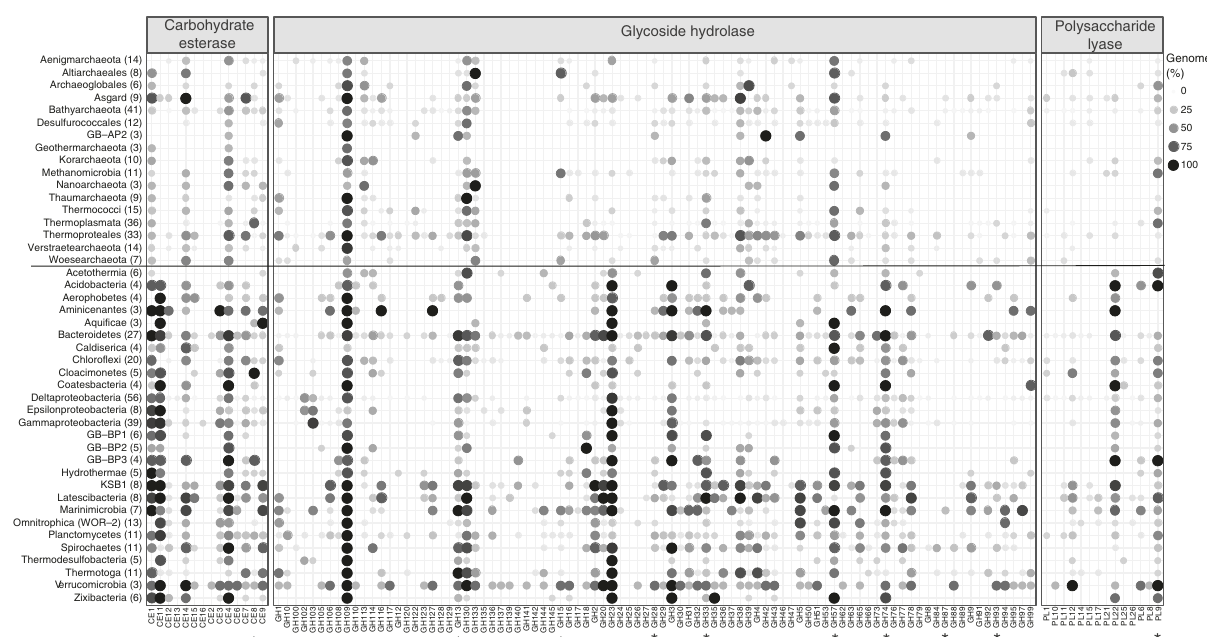
Fig. 3 Number of carbohydrate-active enzymes (CAZymes) encoded in GB genomes. Percentage of carbohydrate esterases (CE), glycoside hydrolases (GH) and polysaccharide lyases (PL) encoded in GB genomes summarized for each phylogenetic cluster. Brackets: Total number of genomes encoded in each phylogenetic cluster. Asterisk: CAZyme with potential secretion signal (see also Supplementary Data